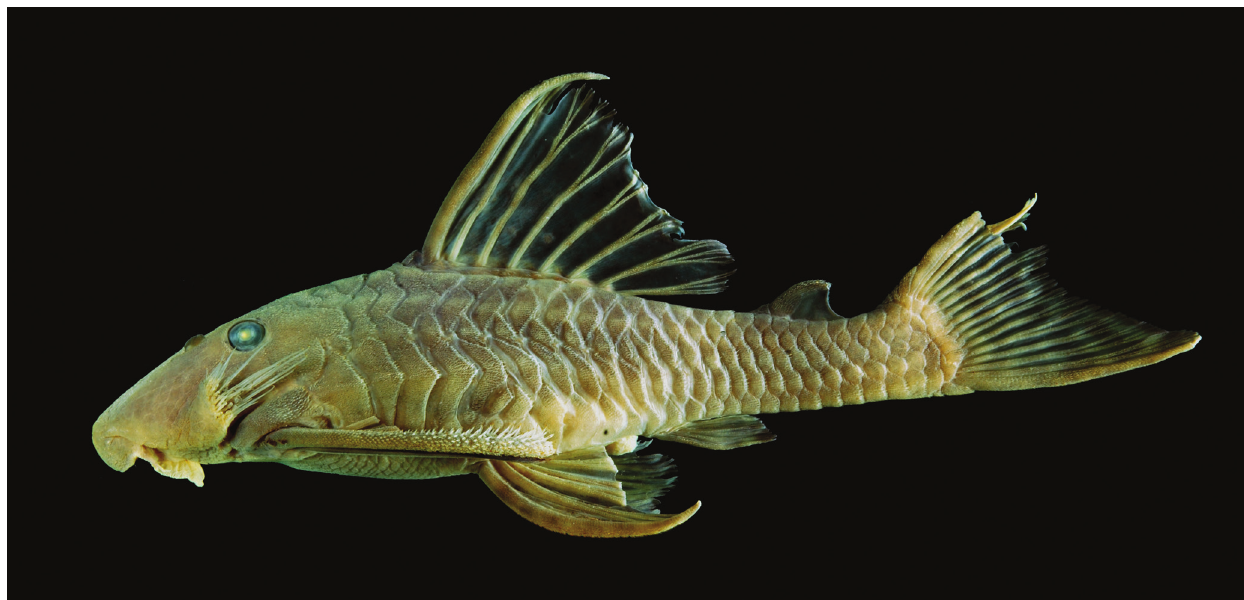
Fig. 5. Lateral view of an adult Panaqolus nocturnus (AUM 45528, 137.4 mm SL) to show the similarity between adult P. nocturnus and P. purusiensis . Photo by B. S. F.